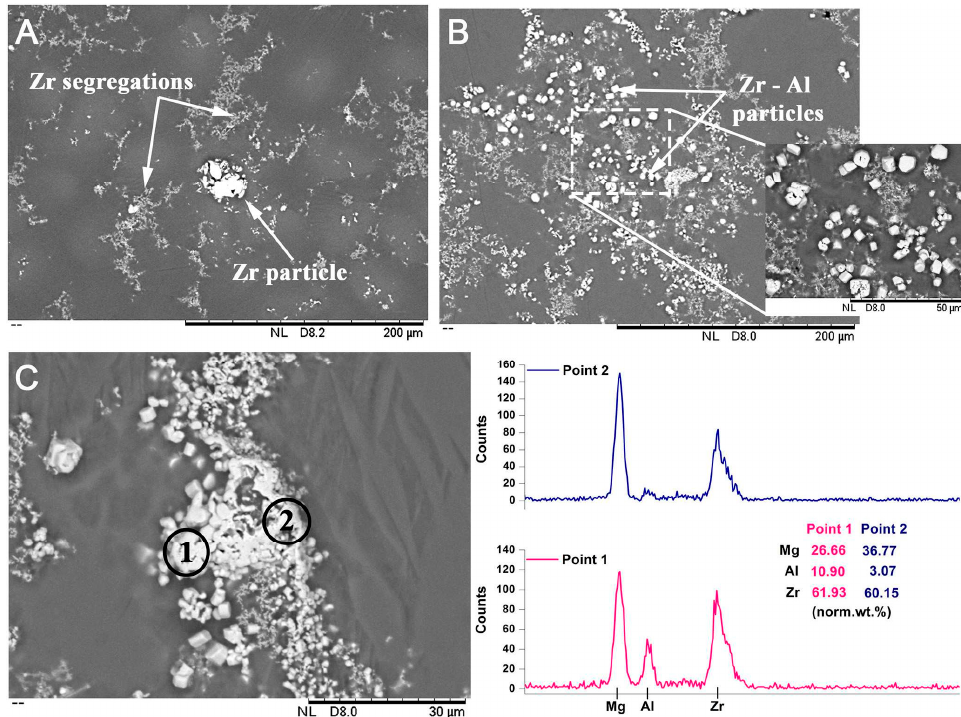
Figure 10. SEM BSE images showing: ( a ) blocky Zr particles and fine Zr particles in Mg-1Zr alloy; ( b ) faceted Zr x Al y particles in Mg-1Zr-Al-Be alloy; ( c ) Zr clusters surrounded by fine precipitates of Zr x Al y particles in Mg-1Zr-Al-Be alloy, EDS testing point 1 is rich in Al and Zr, whereas point 2 is rich in Zr. The samples were cut from the bottom of an ingot to observe the clusters [ 65 ]. Reprinted with permission from ref. [65]. Copyright 2004 Elsevier.